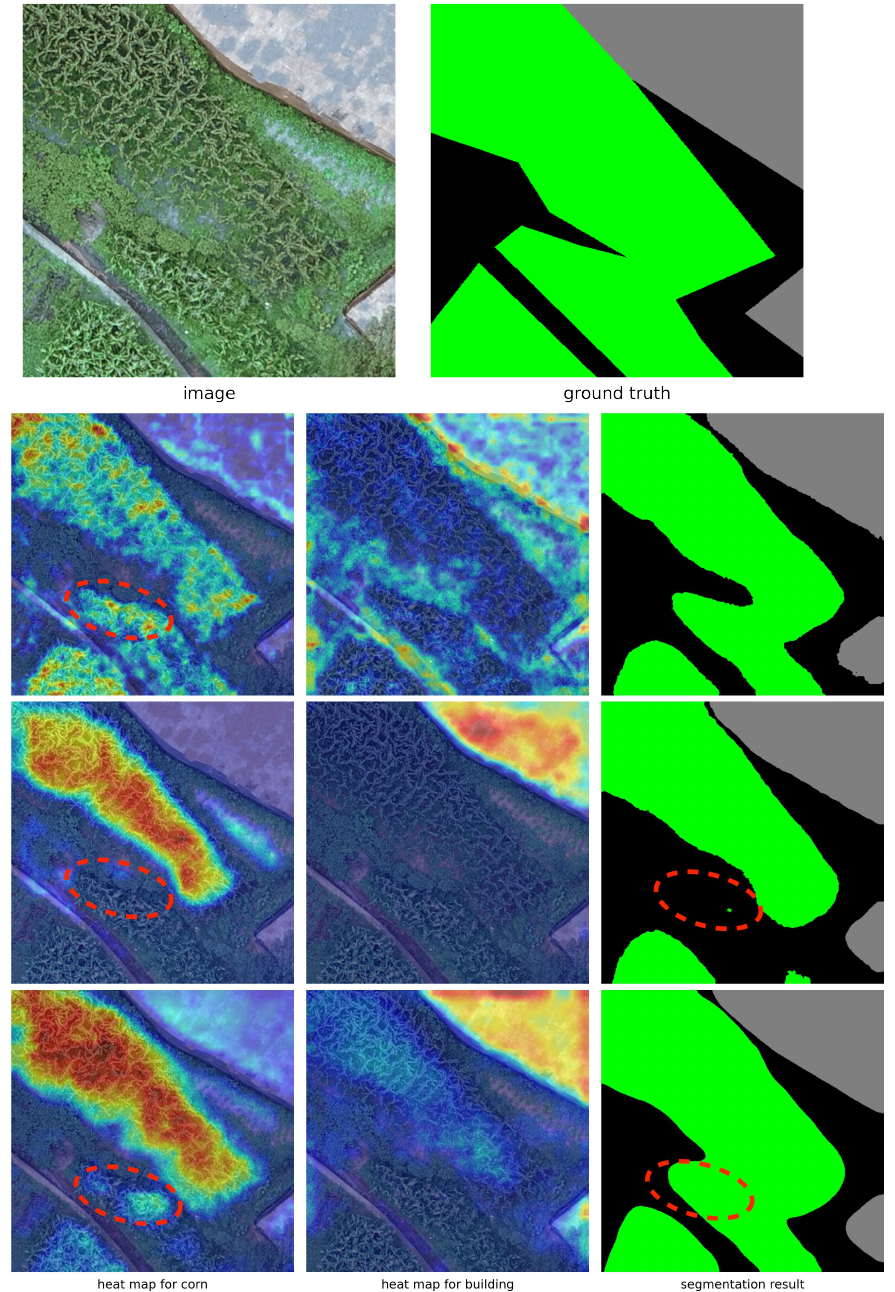
Figure 8. An example of heat map of corn and building. The rows from top to bottom are results from DeepLabV3+, SegFormer and the proposed CTFuseNet,